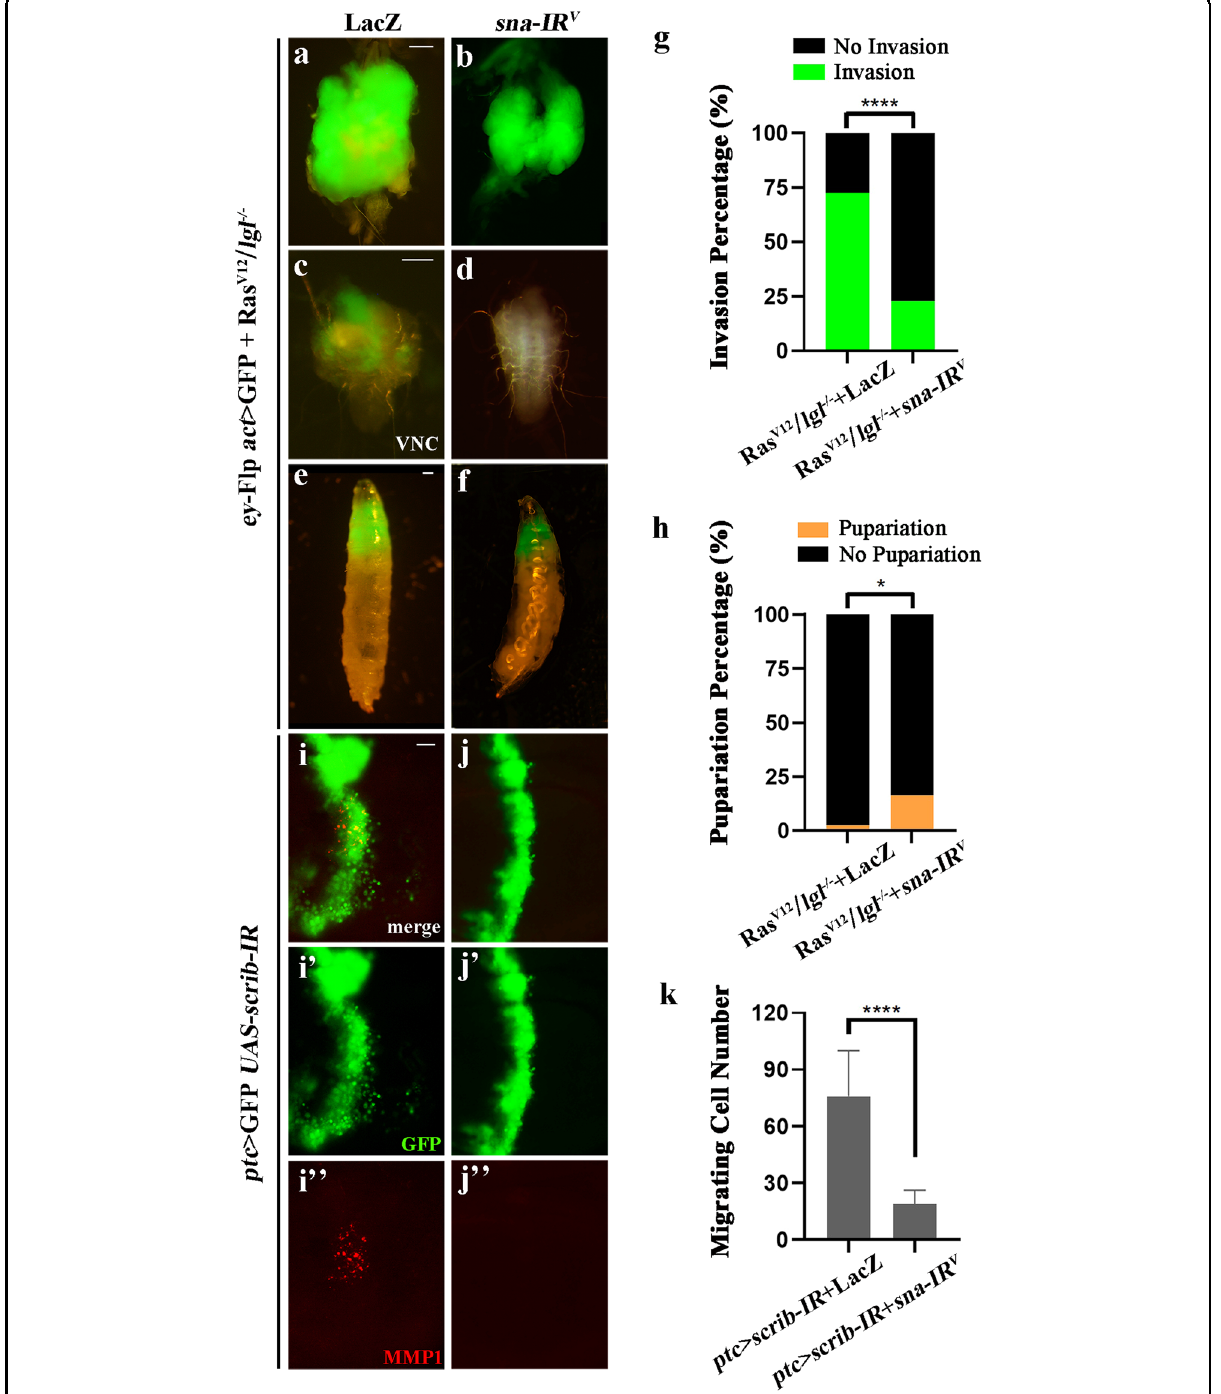
Fig. 3 sna is required for tumor invasion and cell migration. ( a – f , i – i ” and j – j ” ) Fluorescence micrographs of larval CCs ( a , b ), VNCs ( c , d ), whole bodies ( e , f ) and wing discs ( i – i ” , j – j ” ) are shown. Compared with the LacZ controls ( a , c , e and i – i ’’ ), Ras V12 / lgl − / − -induced tumor growth and invasion, and ptc > scrib - IR -triggered cell migration and MMP1 expression were notable blocked by expressing a sna RNAi ( b , d , f and j – j ’’ ). Statistical analysis of the invasion percentage ( g ), the pupariation percentage ( h ) and the migrating cell number ( k ) as shown in fi gures a – b ( a , 72.58%, n = 124; b , 22.81%, n = 114), e – f ( e , 2.56%, n = 39; f , 16.36%, n = 55) and i – j ( n = 10 for each genotype; i , mean = 76.00; j , mean = 19.00) were shown. Chi- squared test or two tailed unpaired t-test was applied to compute P -values, * P < 0.05, **** P < 0.0001. See the electronic supplementary material for detailed genotypes. Scale bar: 100 µm ( a – f ), 20 µm ( i – j